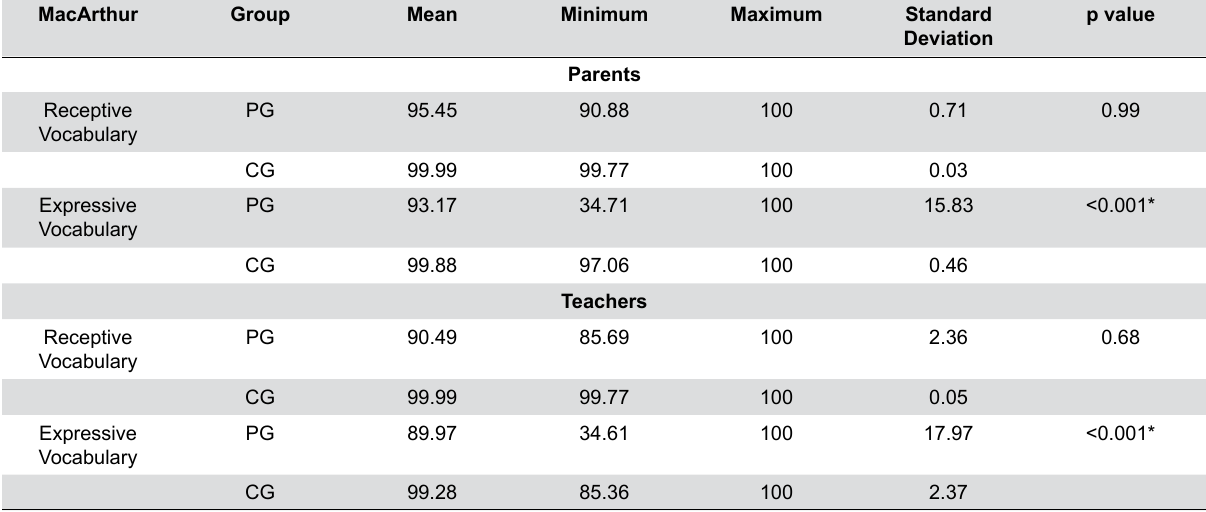
Table 4- Results of the MCDI instrument of the PG compared to the CG, parental report and teachers MacArthur